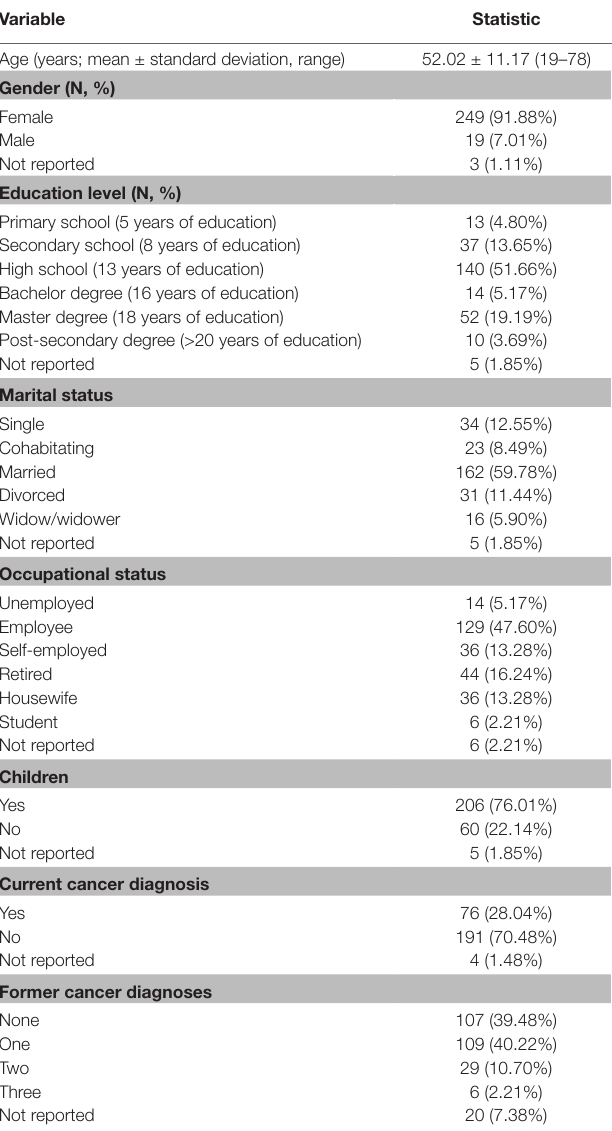
TABLE 1 | Socio-demographic characteristics of the study sample ( n =